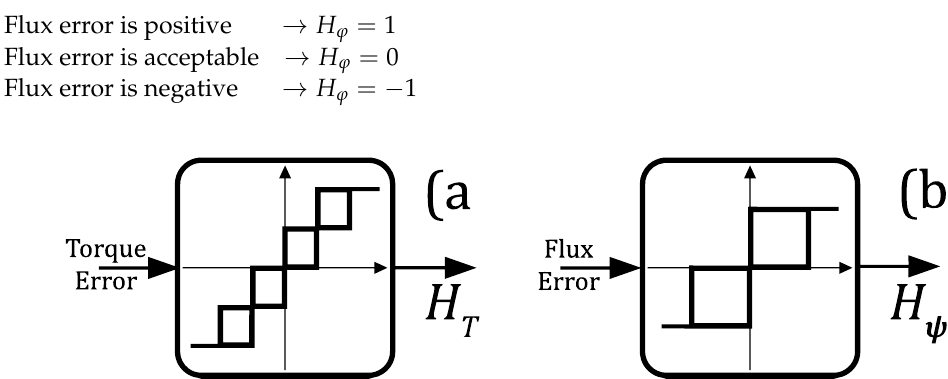
Figure 5. ( a ) The proposed five-level torque controller and ( b ) the three-level flux hysteresis